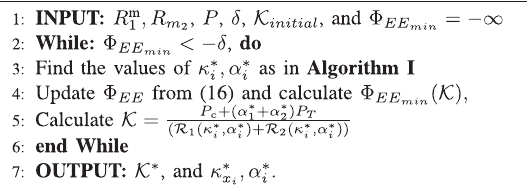
Algorithm 2. : Energy ef fi ciency maximization algorithm.